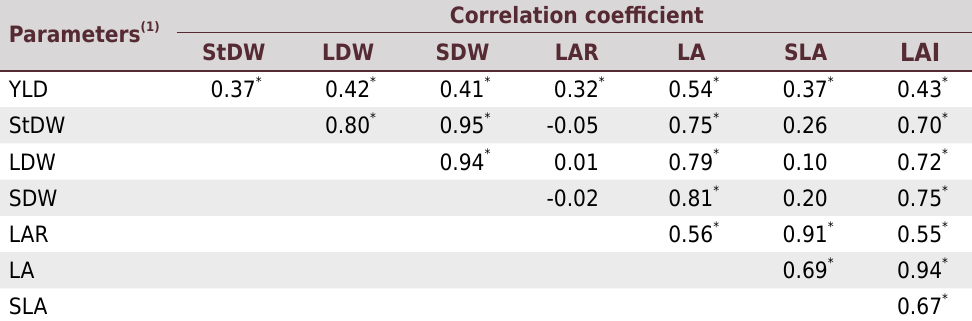
Table 4. Simple linear correlation matrix between soybean yield and the biometric parameters in the second crop (2016/2017) Correlation coefficient Parameters (1) StDW LDW SDW